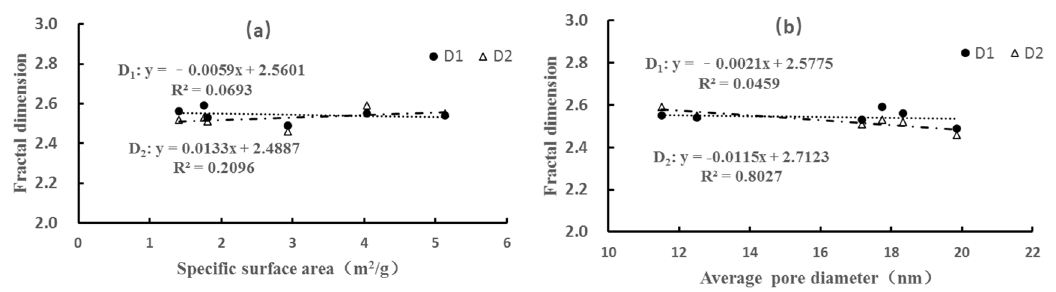
Figure 10. ( a ) Relationship between fractal dimension and SSA; ( b ) Relationship between fractal dimension and APD. Table 7. X-ray CT imaging test results of typical samples.